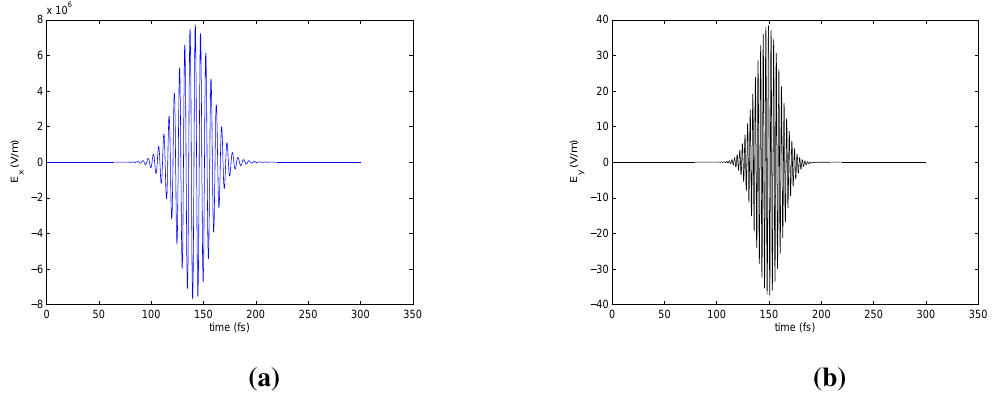
Figure 2. Time history of ( a ) the linear response, and ( b ) the nonlinear response, for U-shaped metallic particles illuminated by a x -polarized incident light.